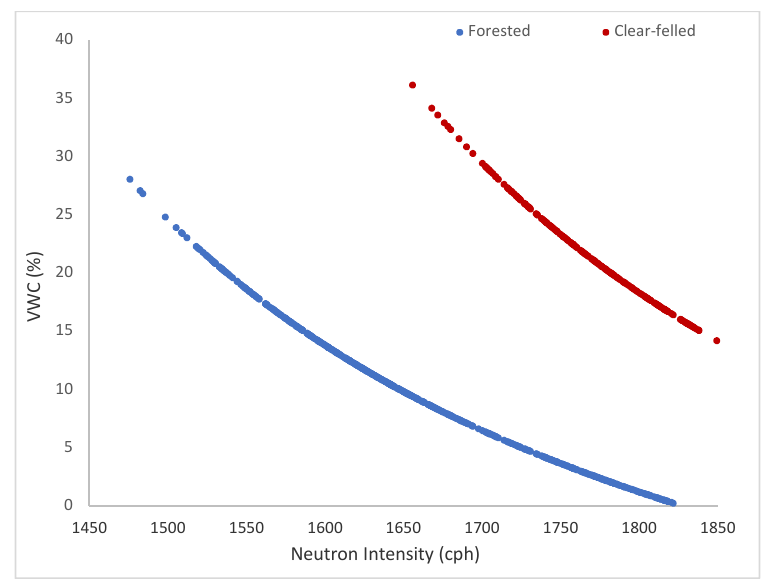
Figure 5. Calibration curves with biomass present (forested) and without the presence of biomass (clear-felled) at the Two-Streams Catchment.